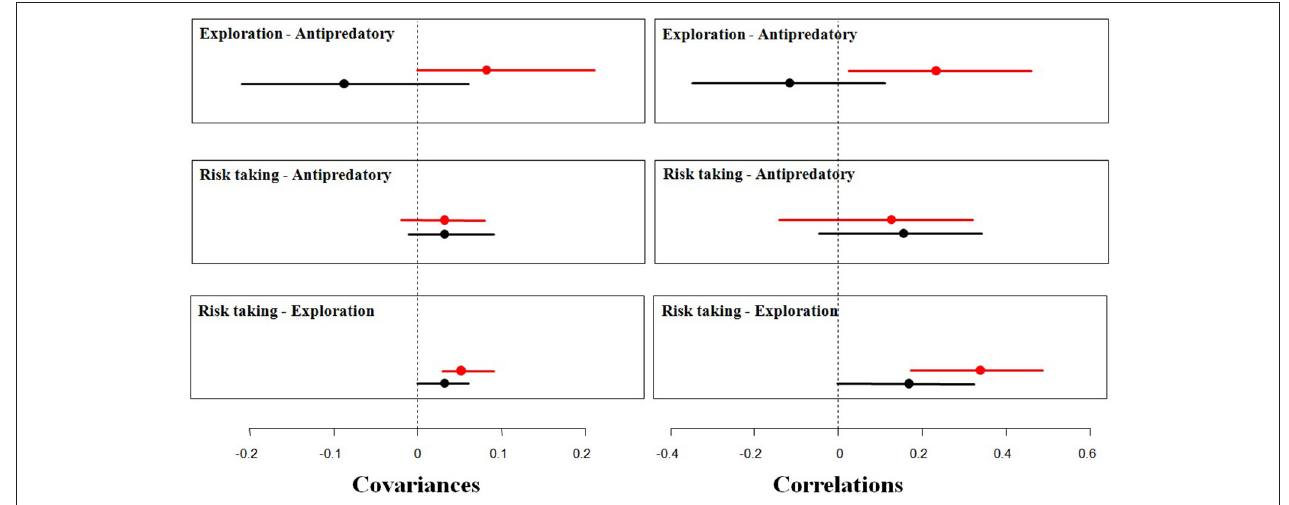
FIGURE 3 | Mean covariances and correlations (points), with their 95% credible intervals (segments), between fear of humans (risk taking behavior, measured as FID), antipredatory response and exploration among urban (red) and rural (black) burrowing owls. The vertical, dashed line represent 0 covariance and